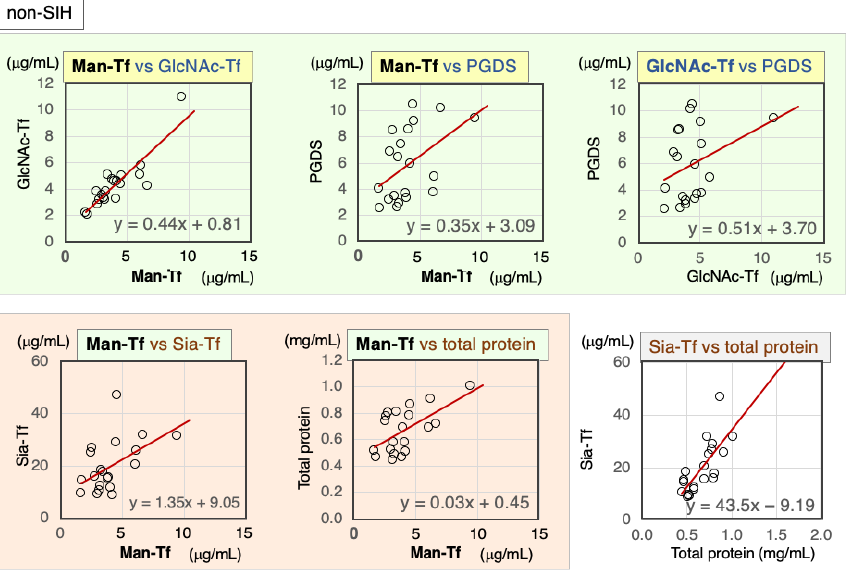
Figure 5. Scatter diagrams and regression lines for marker combinations in non-SIH patients. Table 4. Correlation coefficients and data normality of markers.